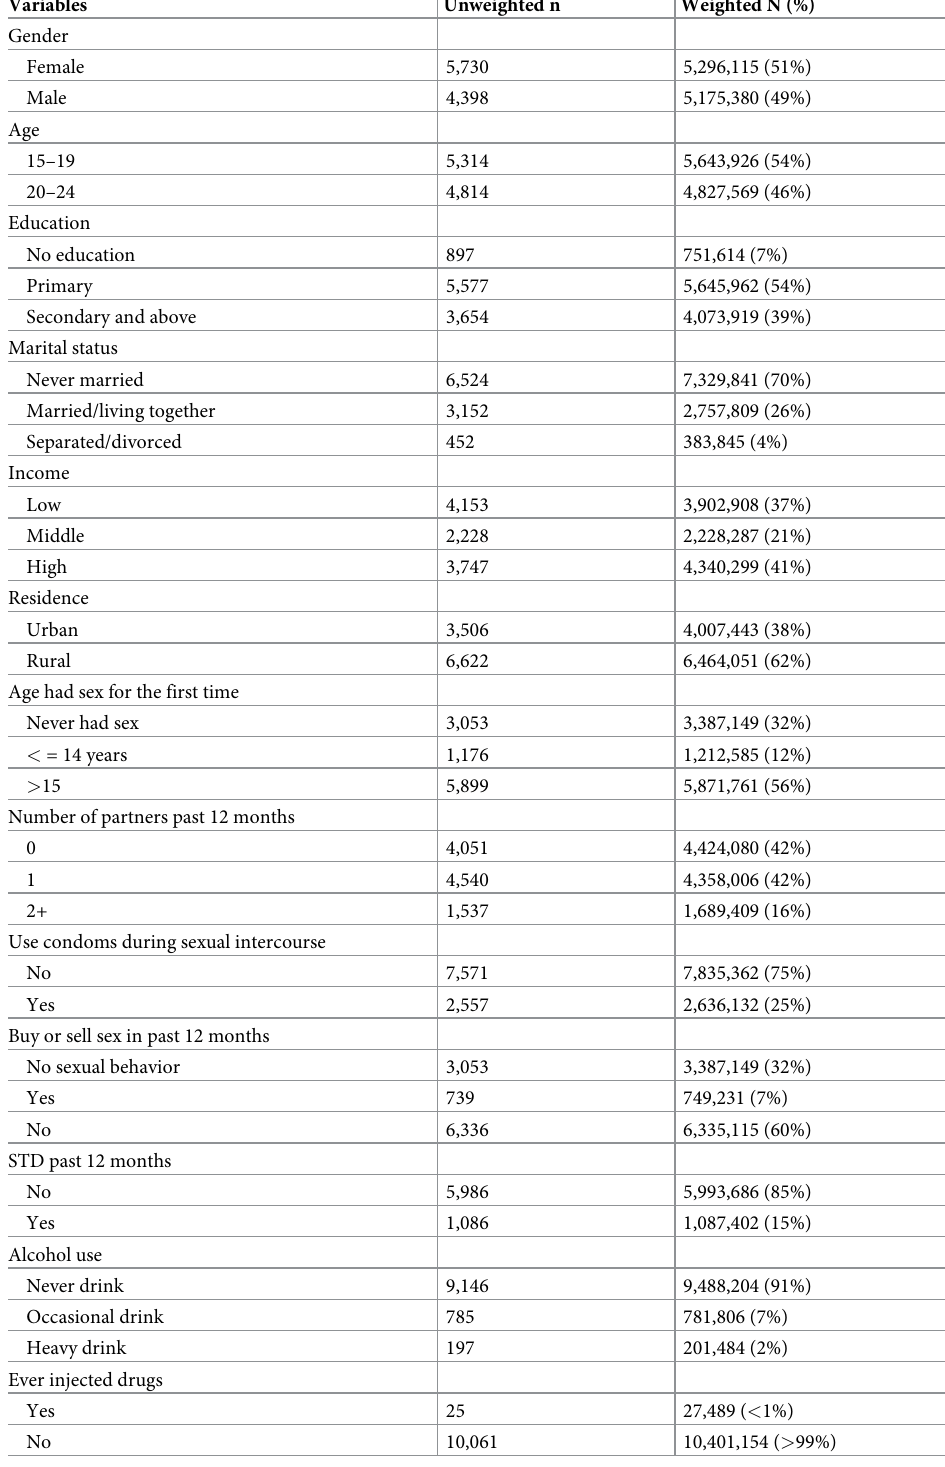
Table 1. Demographic and socio-behavioral characteristics of adolescent and young adults aged 15–25 in Tanza- nia: Tanzania HIV Impact Survey (THIS) 2016–2017 (N = 10.5